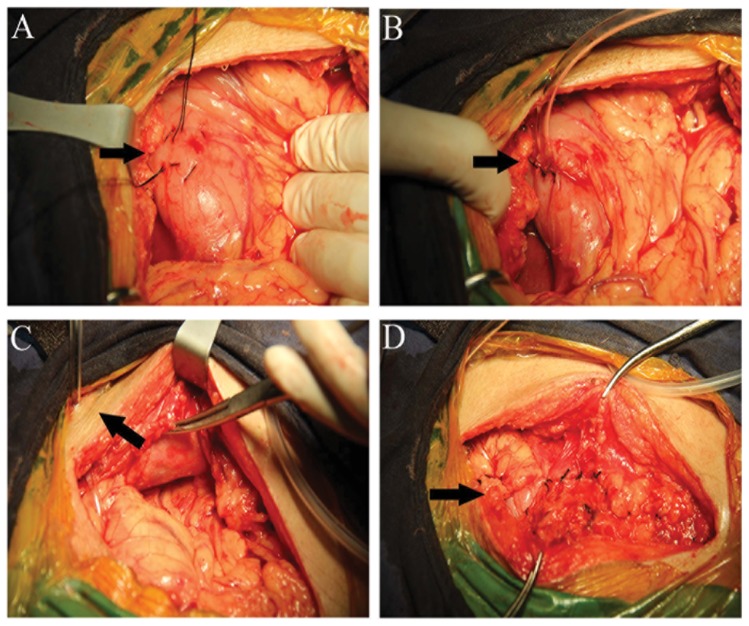
The operative procedure for retrosternal route gastrostomy.(A) The black arrow shows a purse-string suture in the anterior wall of the stomach under the xiphoid; (B) The black arrow shows the feeding tube was inserted through the incision, and 10 to 25 cm of the tube was passed aborally in the intestingal lumen; (C) The black arrow shows the feeding tubes brought out through the anterior abdominal wall; (D) The black arrow shows the omentum and the peritoneum were sutured to the gastric wall near the tube.